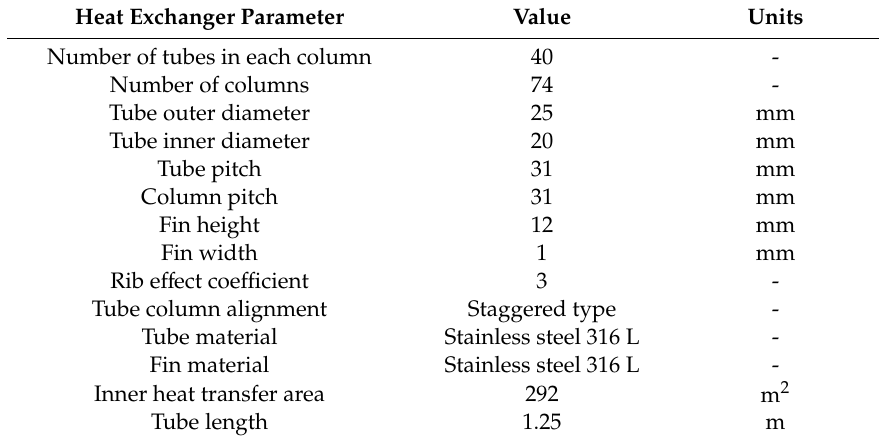
Table 4. Geometrical dimensions of the fin-and-tube heat exchanger of the evaporator 1 of the HT loop.